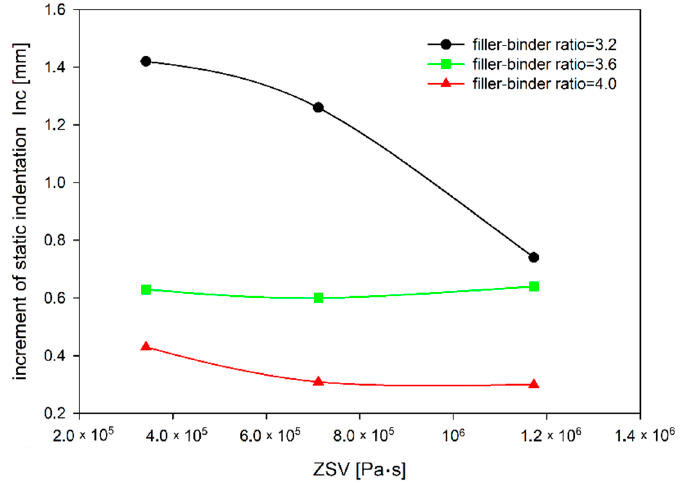
Figure 9. The dependence of increment of MA static indentation on ZSV of TLA-modified binder for different filler–binder ratios.